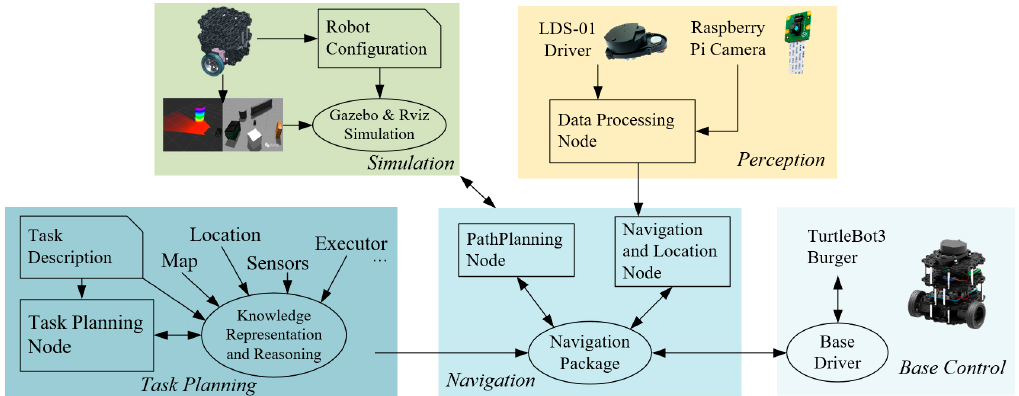
Figure 14. The framework of the software system.